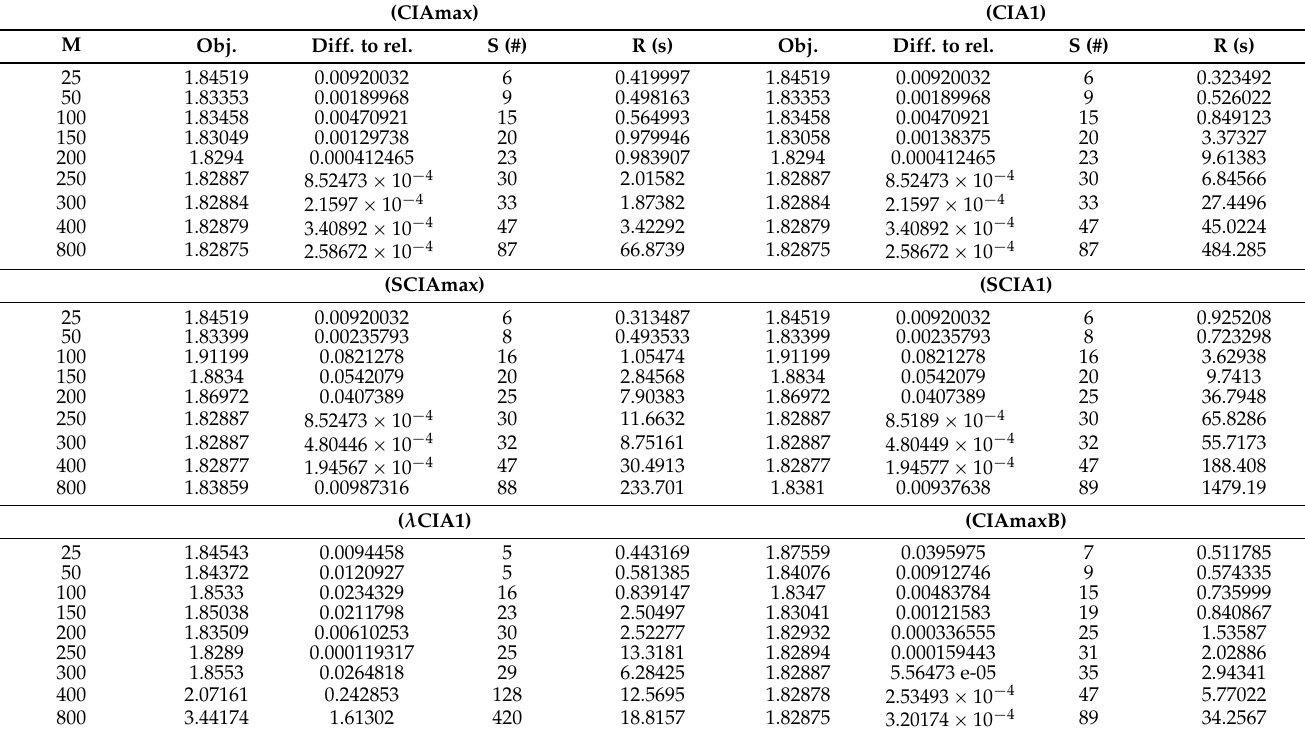
Table A2. Results for the Lotka–Volterra multimode problem with N = 12,000 and varying M . The tables list objective values, differences to relaxed objective, number of switches, and runtime in